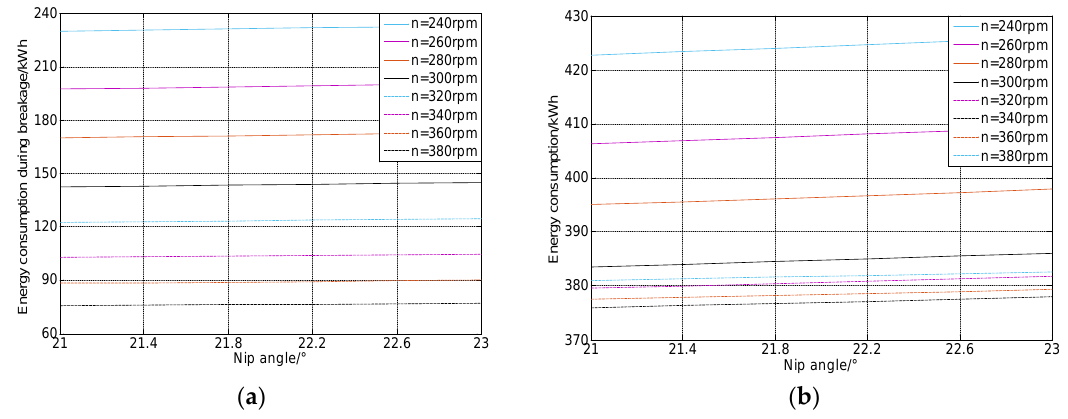
Figure 11. Energy consumption when varying the nip angle and speed: ( a ) relation of nip angle vs. breakage energy consumption; ( b ) relationship of nip angle vs. energy consumption of cone crusher.